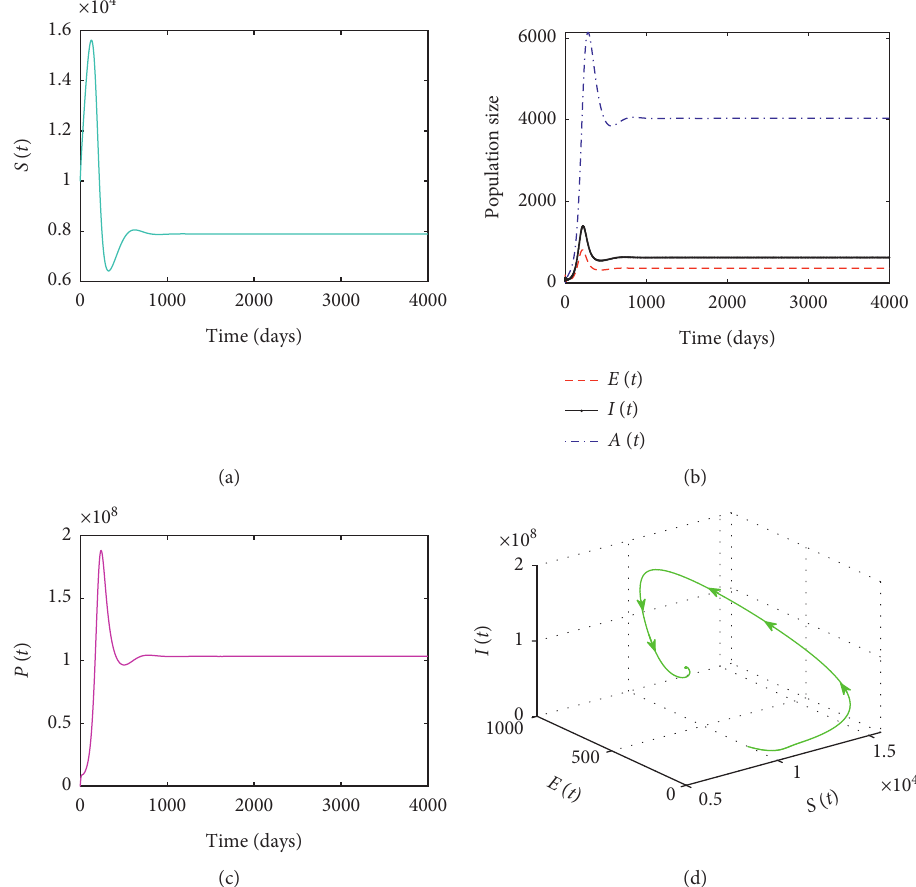
Figure 4: Numerical results of system (1) depicting the persistence of the disease of R Parameter values used to construct the simulations are in Table 1, with f � 0 . 5, p � 0 . 01, and κ � ϵ � 0 . 1, leading to R